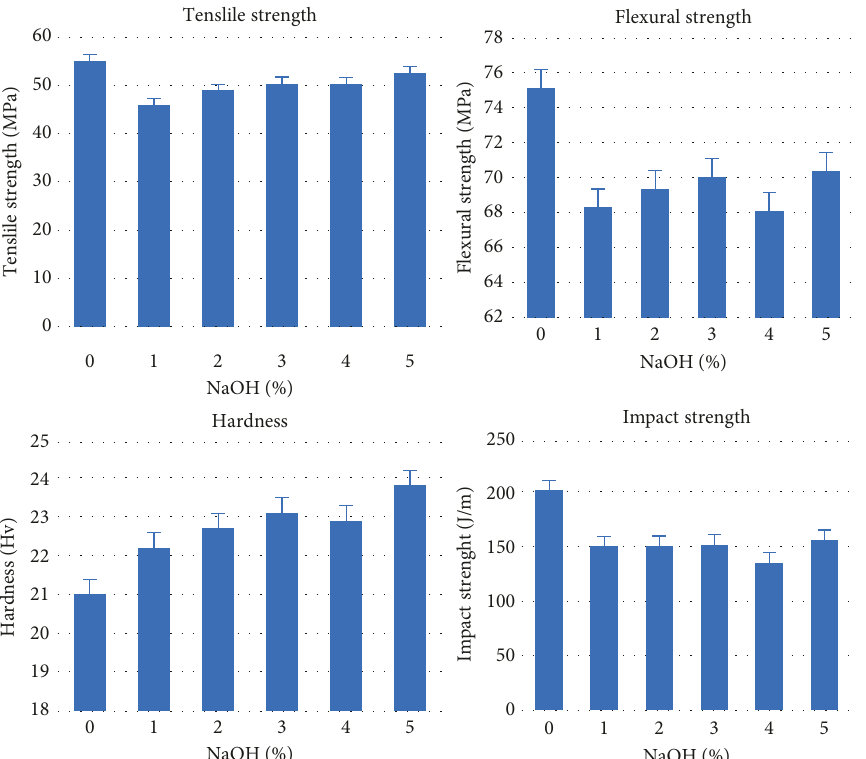
Figure 3: Effect of treated NaOH content on mechanical properties of